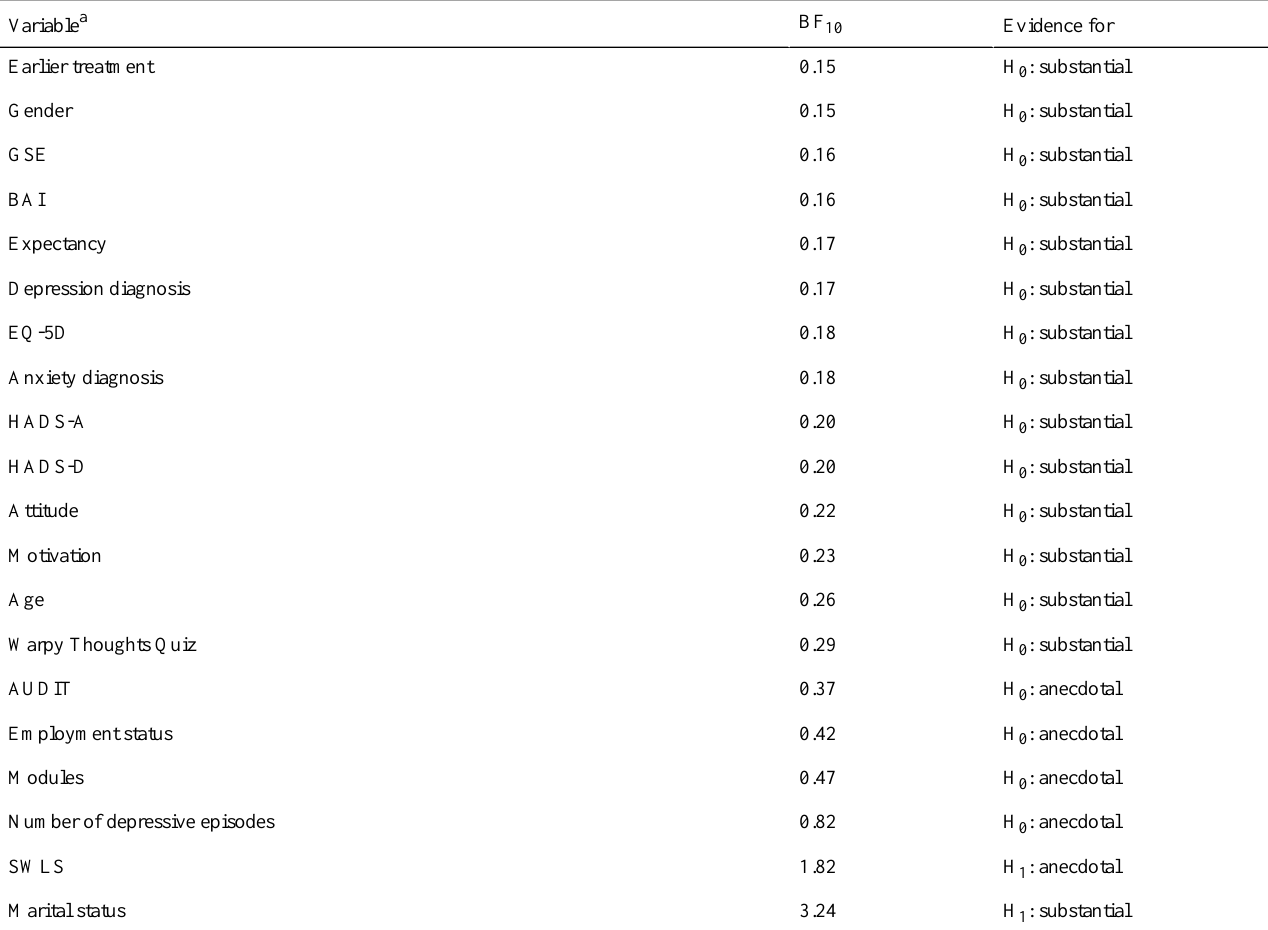
Table 5. Bayes factors (BF 10 ) quantifying the evidence for alternative hypotheses (H 1 ) over the null hypothesis (H 0 ). Variables are sorted with respect to its Bayes factor in ascending order. The null hypothesis is that the predictor does not have an impact on treatment response (H 0 : α 1 =0) and the alternative is that it does have an effect (H 1 : α 1 ≠ 0). BF 10 is the odds for H 1 divided by the odds for H 0